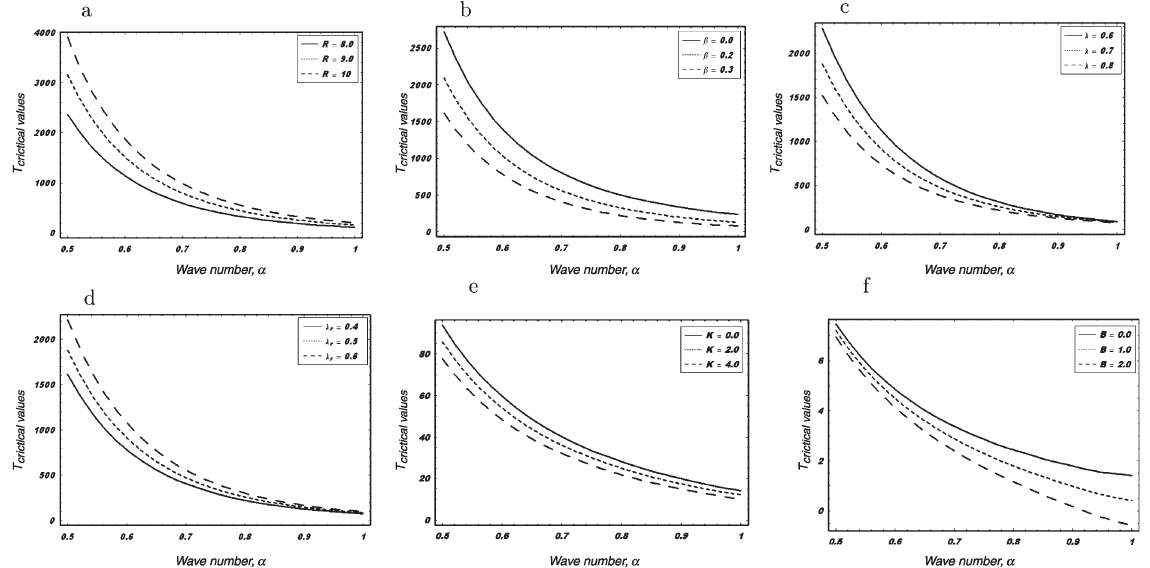
Fig. 3. The variation of critical values of the wall tension T with wave number α for three different values of the Reynolds number R (panel( a )), Burgers’ fluid parameter β (panel( b )), relaxation time λ (panel( c )), retardation time λ r (panel( d )), spring stiffness K (panel( e )) and flexural rigidity B (panel( f )). The other parameters chosen are m = 0 . 01, B = 2, K = 1, d = 0 . 5, λ = 0 . 7, λ r = 0 . 4 and β = 0 . 3 (panel( a )); m = 0 . 01, R = 7, B = 2, K = 1, d = 0 . 5, λ = 0 . 7 and λ r = 0 . 4 (panel( b )); m = 0 . 01, B = 2, K = 1, d = 0 . 5, R = 7, λ r = 0 . 5and β = 0 . 3 (panel( c )); m = 0 . 01, B = 2, K = 1, d = 0 . 5, R = 7, λ = 0 . 7 and β = 0 . 3 (panel( d )); m = 0 . 01, R = 5, B = 2, d = 0 . 5, β = 0 . 3, λ = 2 and λ r = 0 . 7 (panel( e )) and m = 0 . 01, R = 3, K = 1, d = 0 . 5, β = 0 . 3, λ = 1 . 5 and λ r = 0 . 5 (panel( f